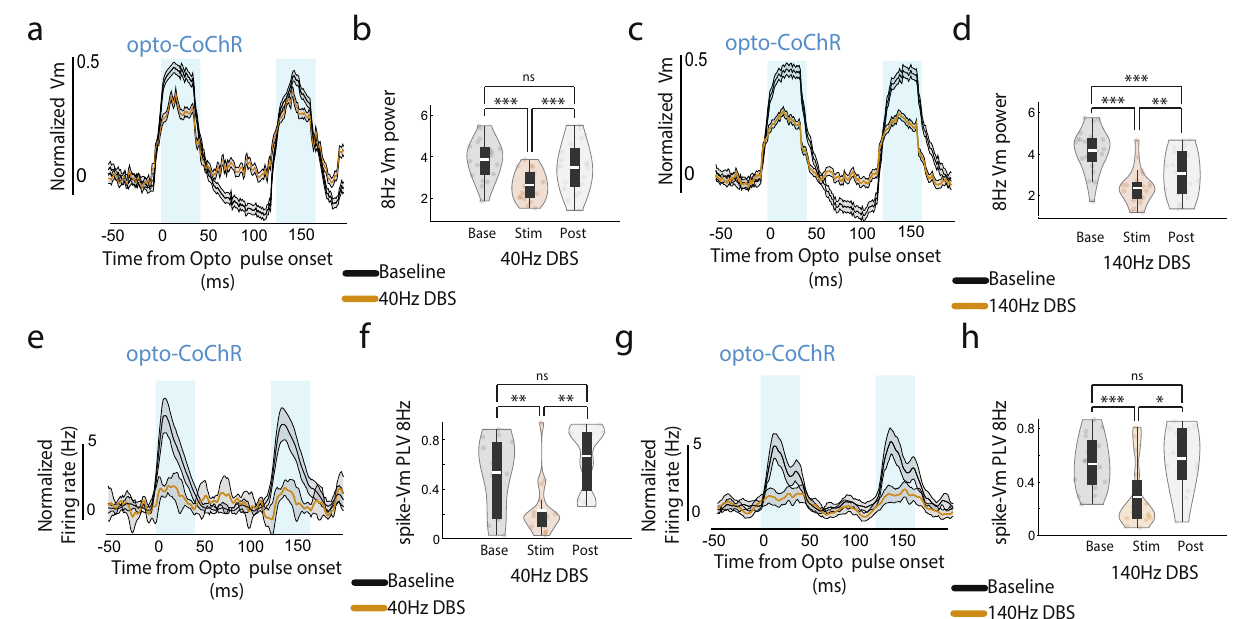
Fig. 7 | DBS reduces a neuron ’ s ability to respond to somatic membrane depolarization inputs evoked optogenetically. a Population-averaged Vm alignedtoblue-lightCoChRpulseonsetsduringbaseline(backline)and40HzDBS (golden line). Shaded area represents SEM. The vertical blue shaded area corre- sponds to the optogenetic CoChR activation period (42ms). The average Vm during the baseline period ( − 50ms to 0ms) was subtracted from the Vm. b Quan- ti fi cation of 8Hz CoChR-evoked Vm power change during baseline (Base), 40Hz DBS (Stim) and post-stimulation period (Post). Data are visualized as violin plots with the outer shape representing the data kernel density and a box plot showing interquartile range (1x, 1.5x). The white lines in the boxes are the mean. Stim vs. Baseline, paired t-test, p =5.22×10 − 7 , df=19. Stim vs. Post, paired t-test, p =5.6×10 − 4 , df=19, Post vs. Baseline, paired t-test, p =0.07, df=19. c , d Same as ( a-b ), but for 140Hz DBS condition. Stim vs. Baseline, paired t-test, p =5.66×10 − 7 ,